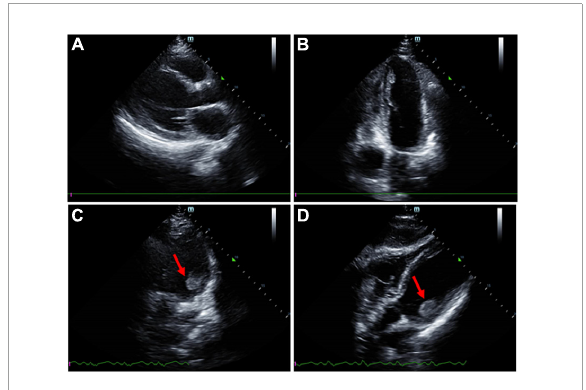
FIGURE3 Transthoracic echocardiogram imaging of the patient. (A) Parasternal window parasternal long-axis view. (B) Apical window four-chamber view. (C,D) A mural thrombus was identified attached to the posteromedial papillary